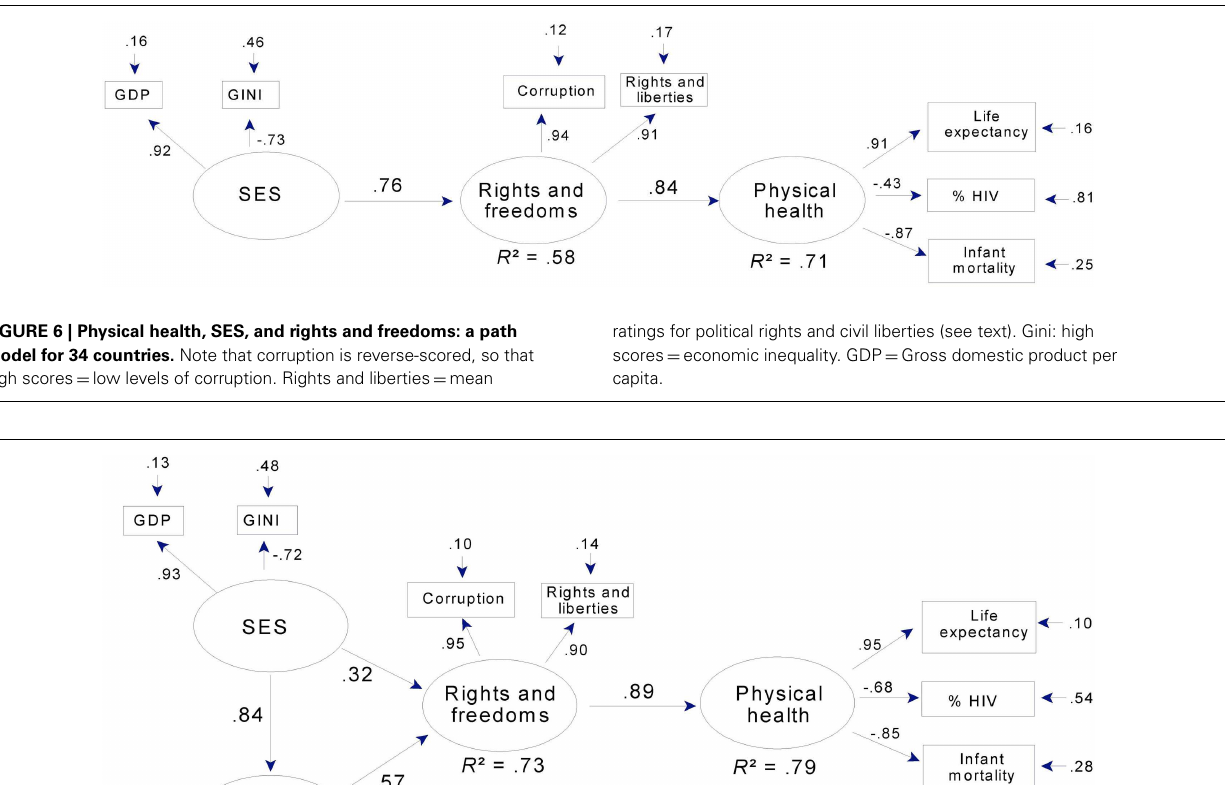
inequality. GDP = Gross domestic product per capita. % trust police = % of WVS sample expressing trust in police. % members of other organizations = % ofWVS sample who were active or inactive members of non-religious, non-labor